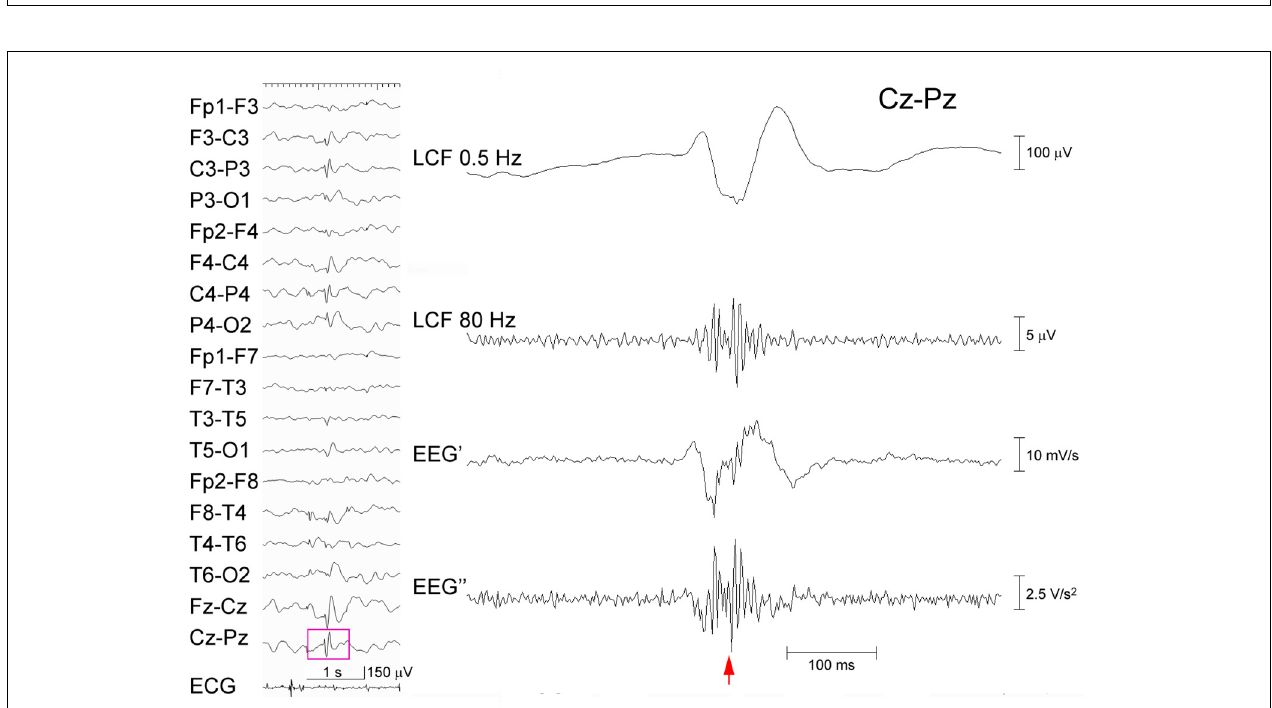
FIGURE 2 | Processing of an EEG epileptic discharge. A spike-wave recorded from a 5-year-old boy (left panel). The EEG data (pink rectangle) at Cz–Pz including the spike (arrow) is temporally expanded and processed (right panel) as in Figure 1 . Ripple oscillations can be seen in both the trace LCF filtered at 80 Hz and the EEG (cid:48)(cid:48) trace. The corresponding time–frequency analysis is shown in Supplementary Figure 1B .